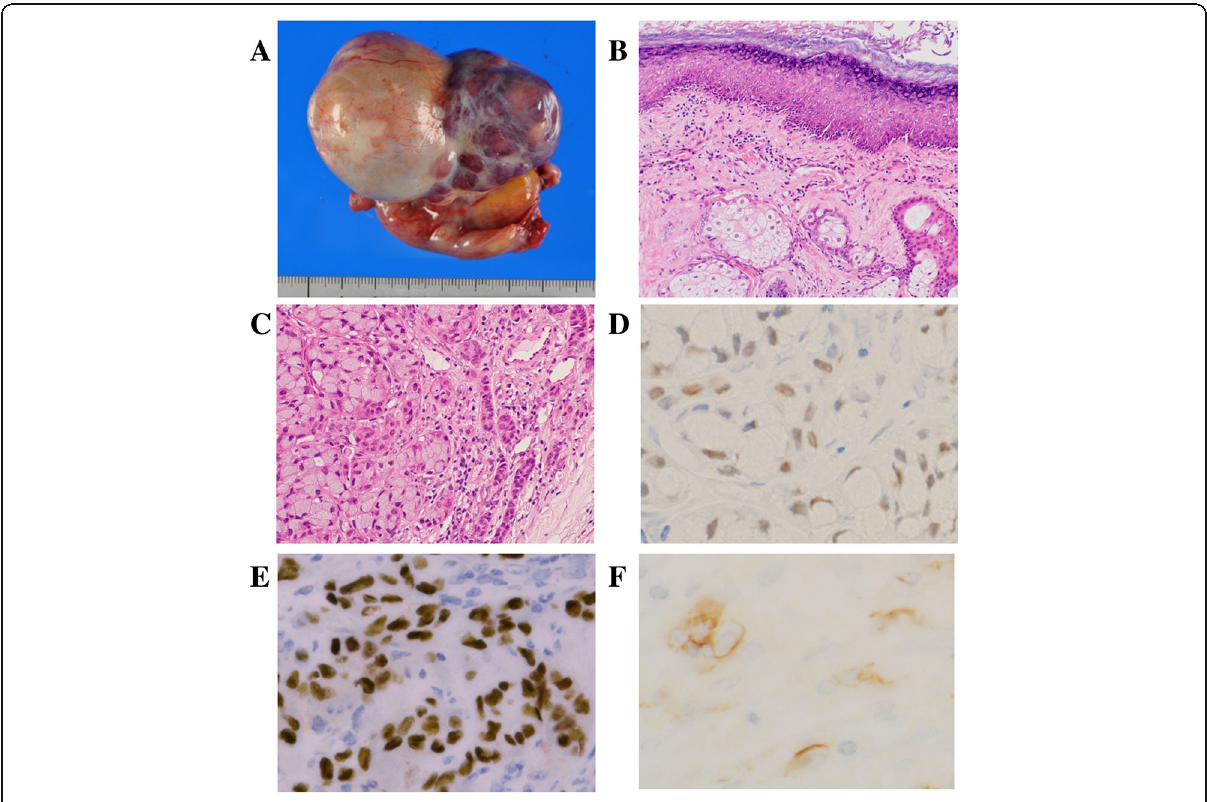
Fig. 2 Right ovarian tumor. a Macroscopic examination shows a cystic tumor filled with greasy, yellow sebaceous material and a firm, well-demarcated, white nodule. b Microscopic examination shows the cystic wall covered with keratinizing stratified epithelium (H&E). c Microscopic examination shows the firm nodule consisted of neoplastic glandular components that contained scattered mucinous cells with signet ring features, focally forming small clusters without distinct glandular lumens (H&E). Immunohistochemical staining shows ( d ) CDX-2, ( e ) SATB2, and ( f ) CD56 (focal)